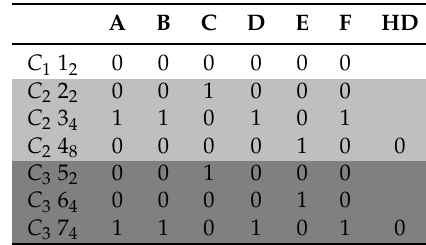
Table 3. Example of a first assignment in the grid for the Figure 2 DAG task using the DAG task paths (each solution is shown in a different shade of gray).